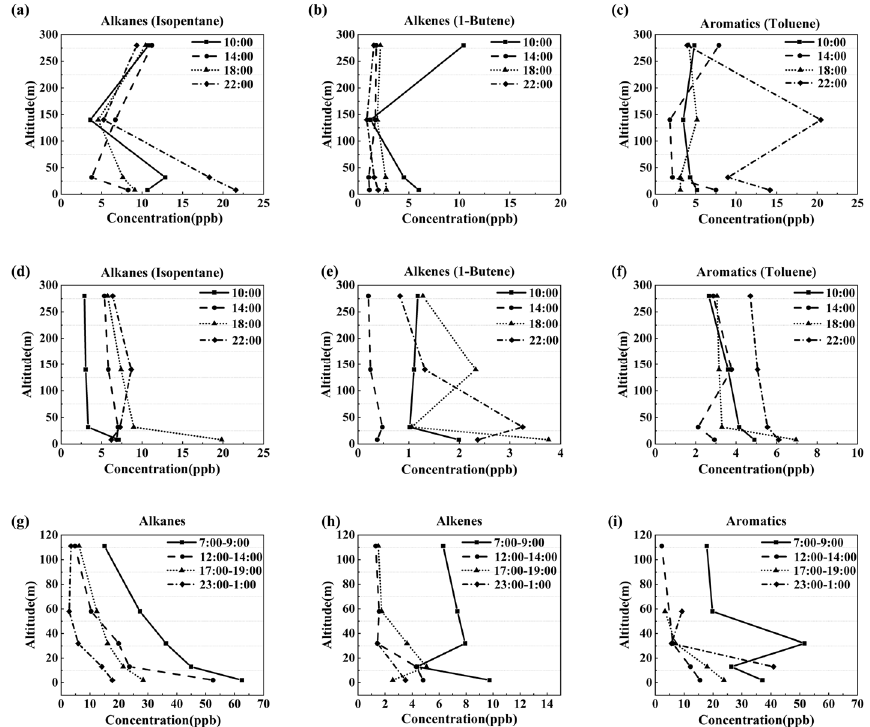
Figure 1. Average profiles of vertical distributions of VOCs in ( a – c ) Beijing haze days, ( d – f ) Beijing clear days, and ( g – i ) Kaohsiung clear days [18,83].